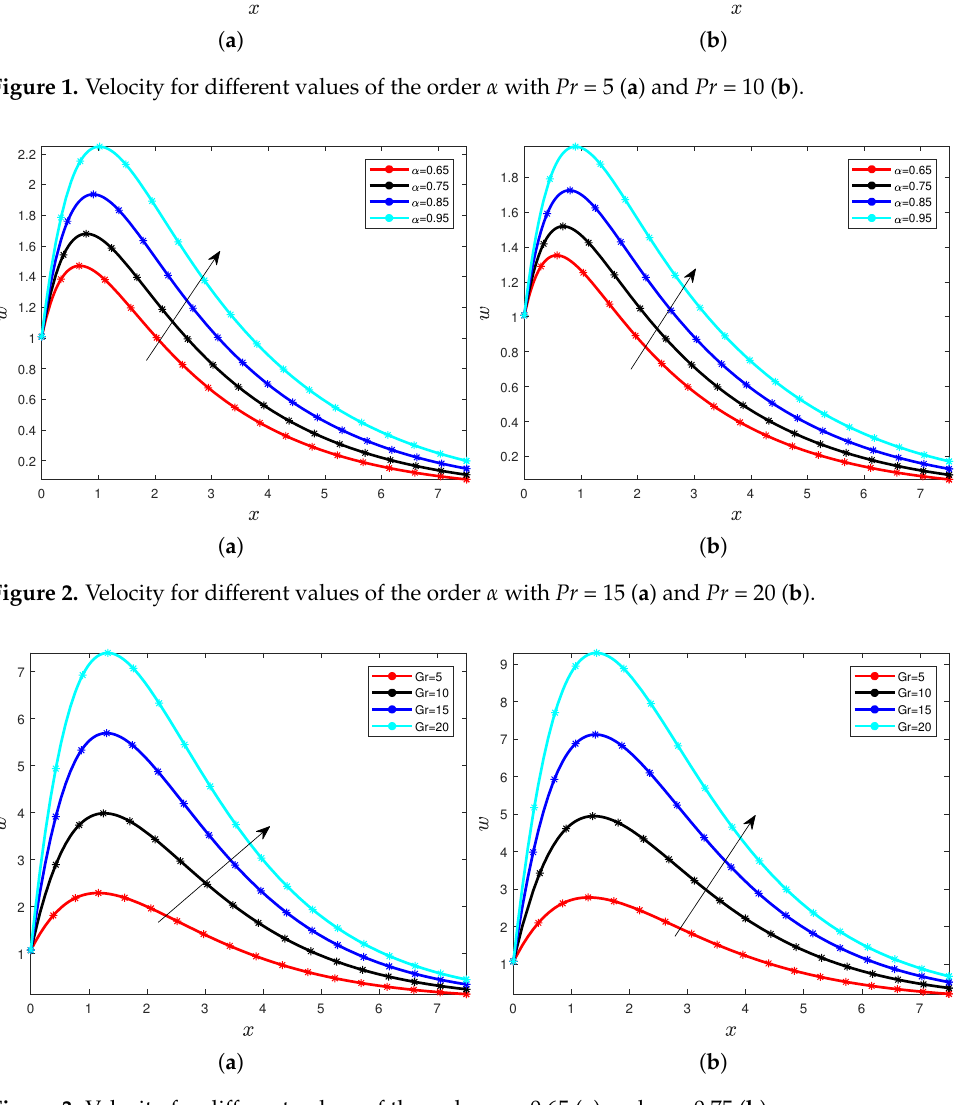
Figure 3. Velocity for different values of the order α = 0.65 ( a ) and α = 0.75 ( b